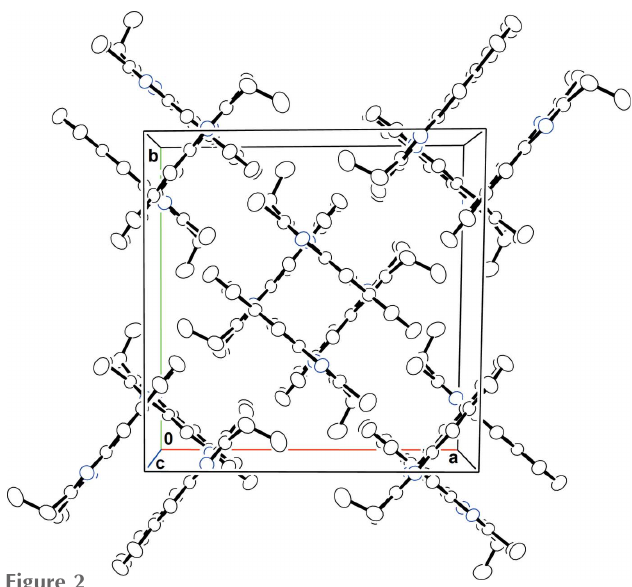
Figure 2 A view of the unit cell of the title compound along